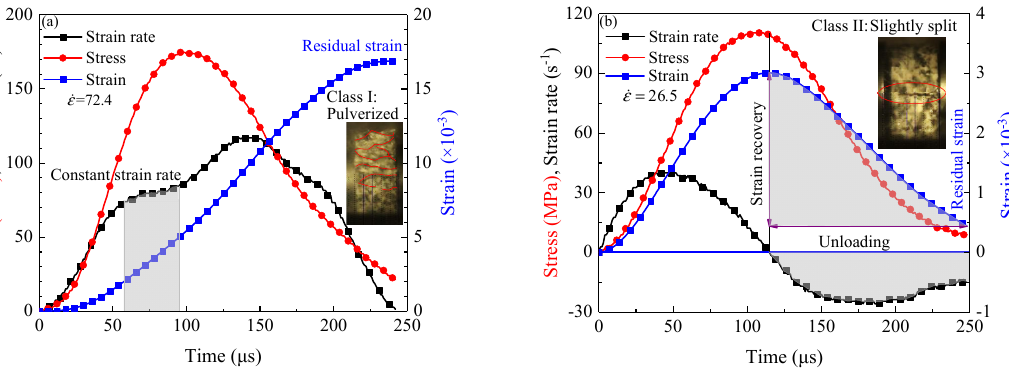
Figure 15. Variation curves of stress, strain rate and strain of specimens at 20°C with time. ( a ) 0.9 MPa; ( b ) 0.5 MPa.